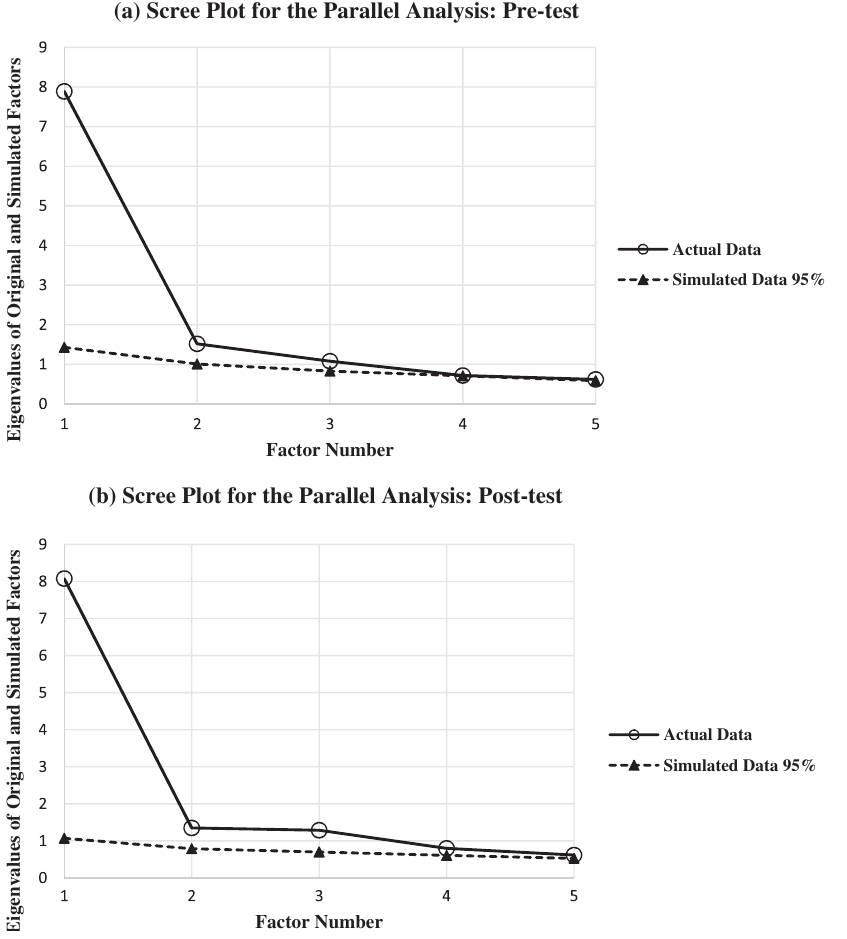
FIG. 2. The (partial) scree plots resulting from the parallel analysis for the pretest (a) and post-test (b) cases. As shown, for each case, five eigenvalues from the original data ’ s correlation matrix were found to be larger than the eigenvalues of the correlation matrix for the simulated data. This suggests that there are five factors for each case, pre- and post-test. For the post-test case, we actually decided to use six factors (please see text for explanation). The other eigenvalues for the original data take on values lower than those for the simulated data. Each eigenvalue for the simulated data is calculated at a 95% confidence